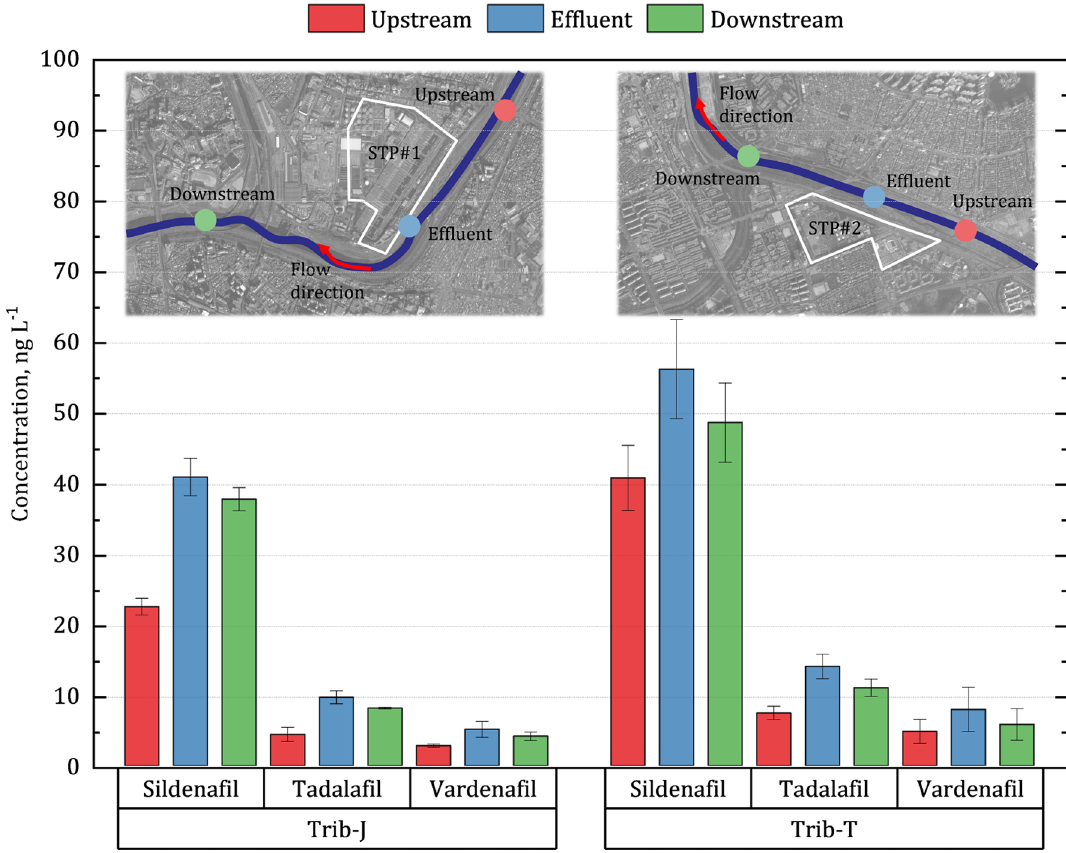
Figure 1. PDE-5i concentrations of effluent from STP#1 (from Trib-J) and STP#2 (from Trib-T) and water samples collected upstream and downstream of STPs. Satellite images obtained from the National Geographic Information Institute of Korea (http:// map. ngii. go. kr).